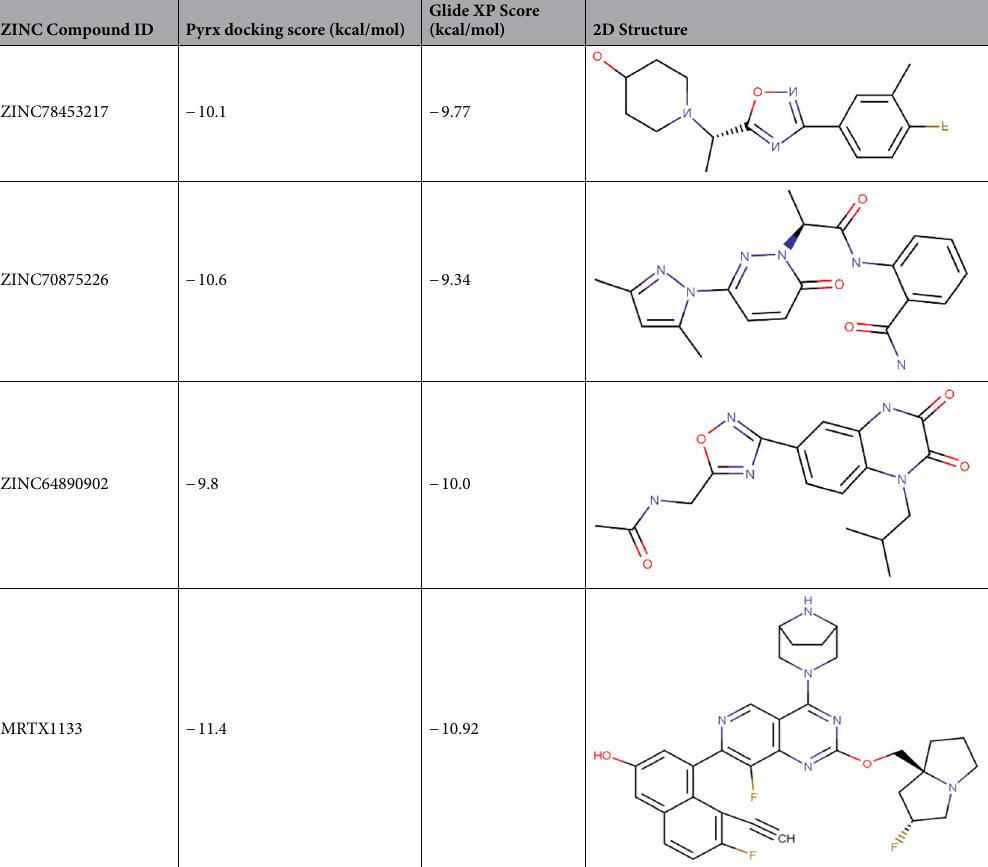
Table 3. Summary of binding energy scores obtained from PyRx and Glide XP for the identified top four compounds.